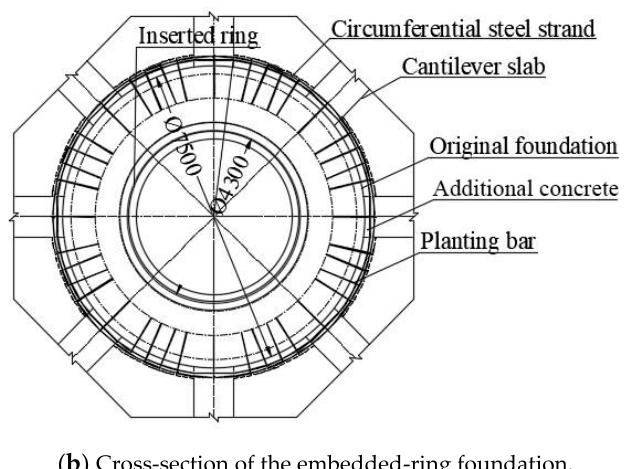
( b ) Cross-section of the embedded-ring foundation. Figure 4. Strengthening method of circumferential prestress. Figure 4. Strengthening method of circumferential prestress. Figure 4. Strengthening method of circumferential prestress.